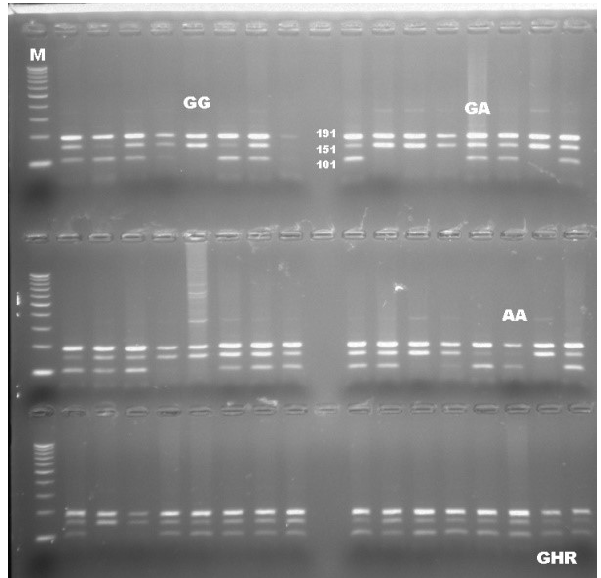
Figure 1. Electrophoretic separation of PCR products digested with AluI for the GHR